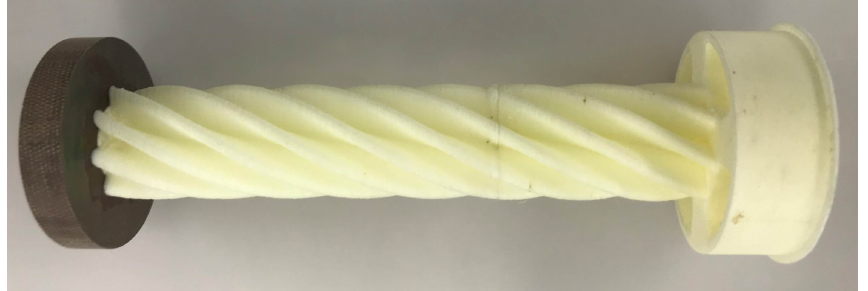
Figure 5. The two moldings are glued together (white-yellowish) and onto the vortex disk (dark brown)